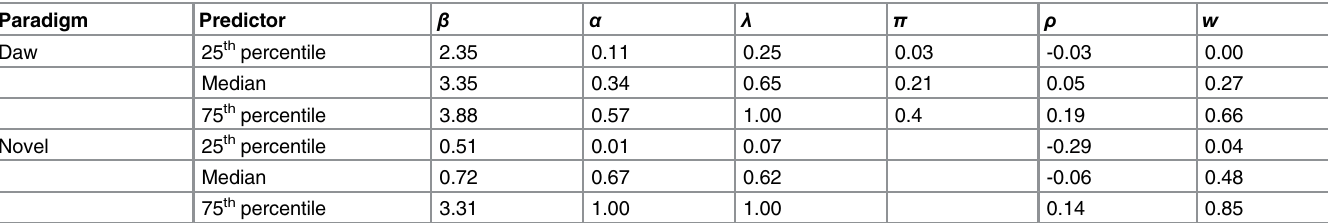
Table 1. Best-fitting parameter estimates shown as median plus quartiles across participants. Paradigm Predictor